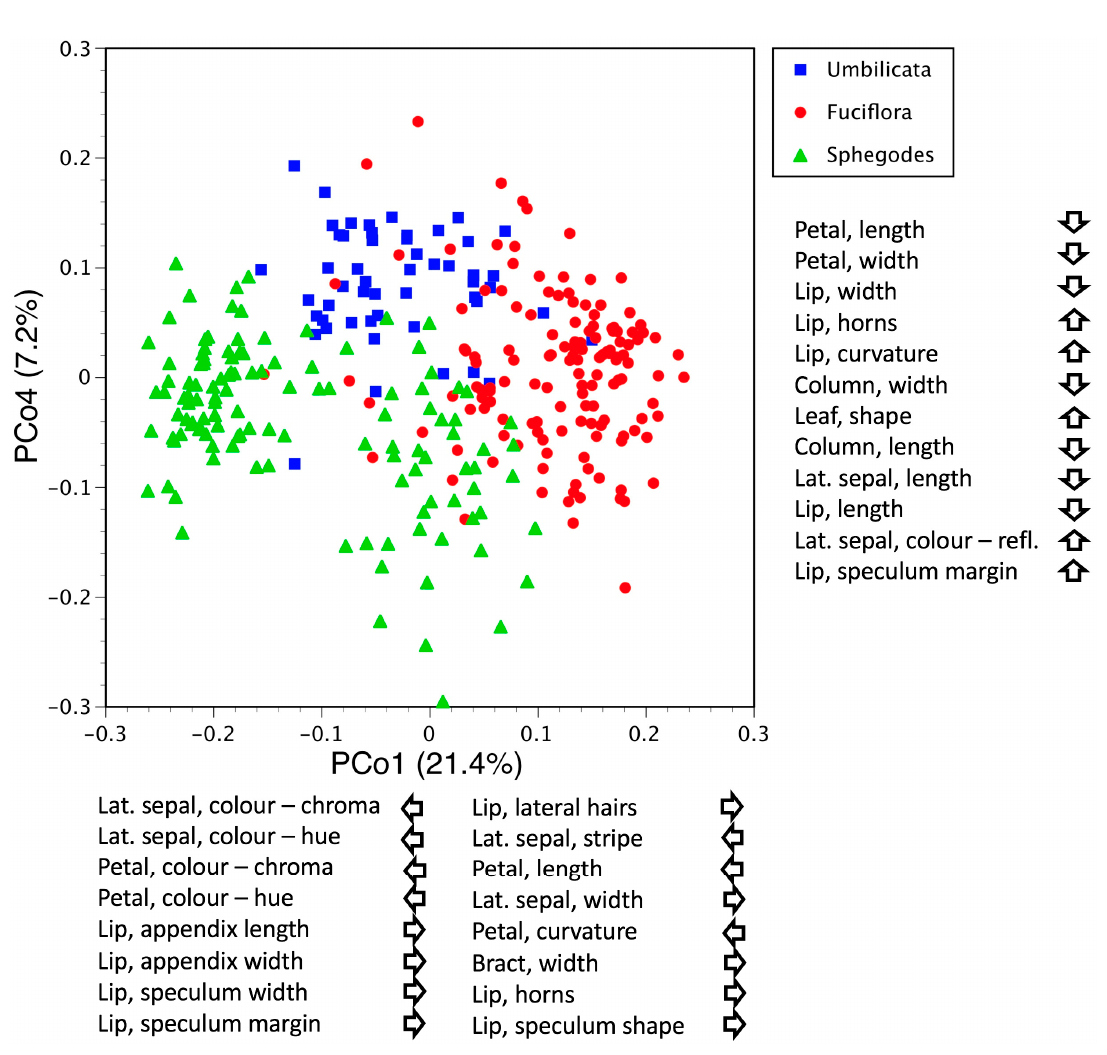
Figure 6. Plot of principal coordinates 1 and 4 for the macrospecies Umbilicata plus Fuciflora plus Sphegodes, labelled according to three macrospecies groups: 319 individuals from ca. 200 localities and 51 variable characters. Characters contributing to each coordinate are listed in descending order, with arrows indicating the direction of increase in the value of each character. The second and third coordinates were much weaker than the first and provided little taxonomic separation. Only when reaching down to the fourth coordinate (Figure 6) was Umbilicata partially separated from Fuciflora and Sphegodes, on the basis of its smaller petals and columns, and (for many Umbilicata microspecies) also the narrower, more three-dimensional labella bearing prominent horns.